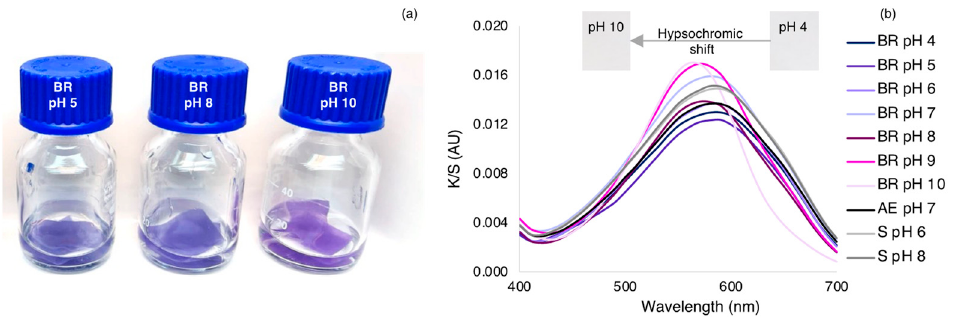
Figure 5. ( a ) Silk samples dyed at pH 6 dipped in different buffer solutions and corresponding color change at higher pH; ( b ) K/S spectra of silk fabrics dyed at pH 6 and dipped for 1 h in different buffer solutions (BR, Britton–Robbinson, AE–artificial wound exudate, S–artificial sweat). Table 6. Color coordinates (L*-lightness, a*-yellowness/blueness, and b*-redness/greenness), K/S, ∆ E, and UPF of the samples functionalized with AzoIz.Pip and immersed in bu ff er solutions to as- sess the halochromic properties of the samples.